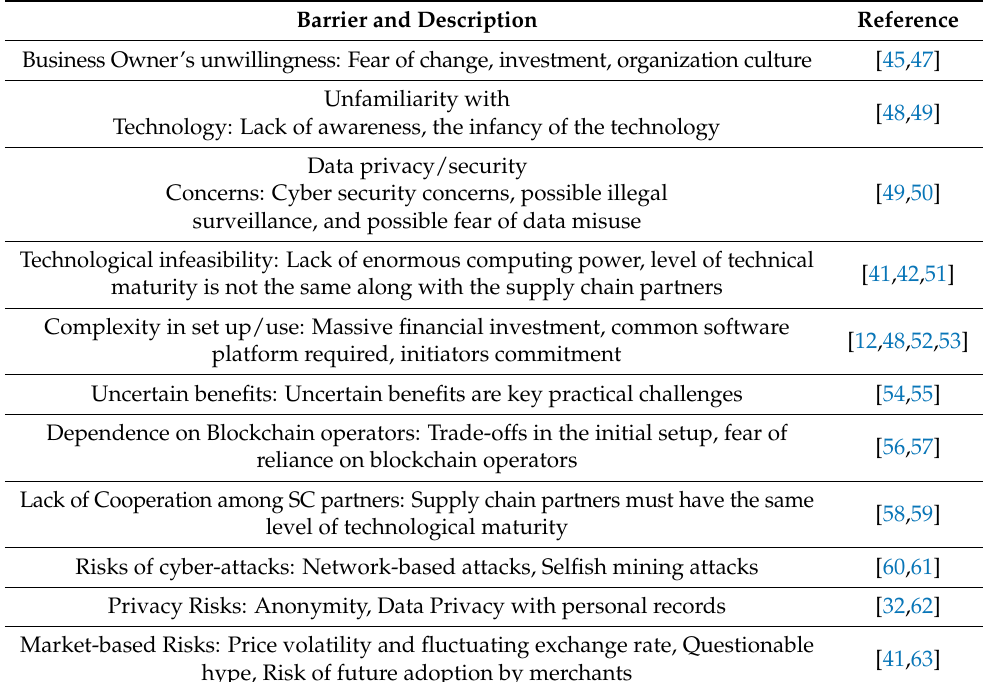
Table 1. Barriers to the application of blockchain technology in the supply chain. Barrier and Description